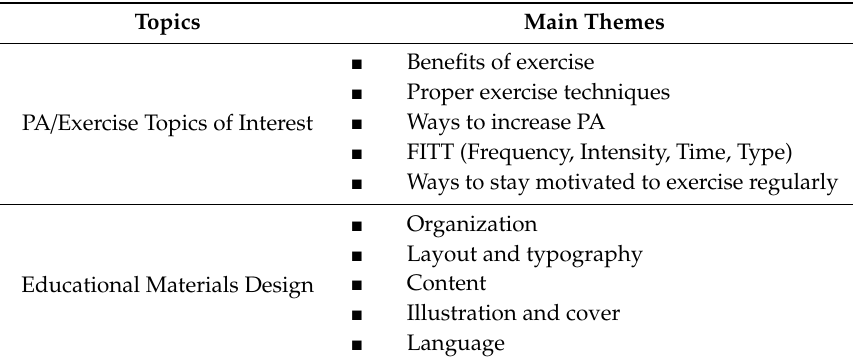
Table 2. Summary of main themes for qualitative